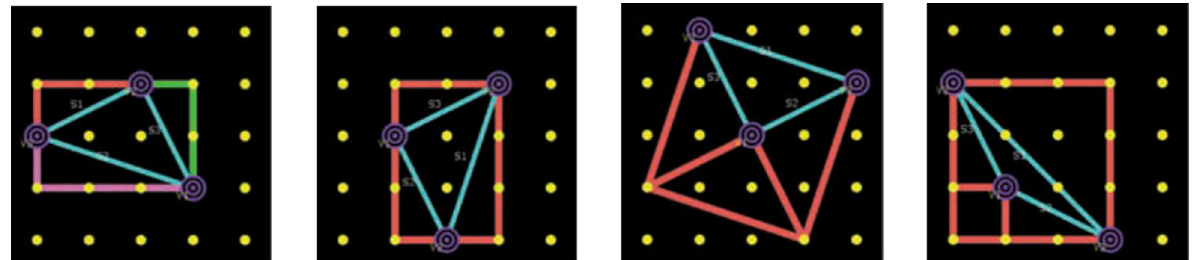
Fig. 10 Student discovered strategies for calculating the area of a triangle in Lattice Land (Pei et al., 2018, p.